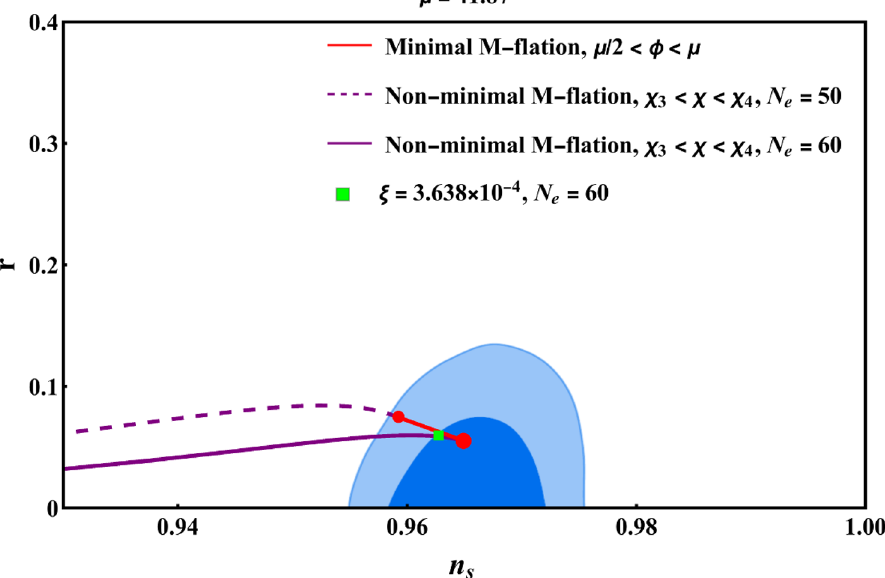
Figure 3 . This (cid:12)gure depicts the evolution of non- M -(cid:13)ation predictions in the hilltop region (cid:31) 2 < (cid:31) < (cid:31) 4 . Enhancing the value of (cid:24) slightly one runs out of the PLANCK 2 (cid:27) viable region in the n S (cid:0) r plane. Also the length of in(cid:13)ation shortens. The green square dot corresponds to the value of (cid:24) for which only the stable part of the potential in this region supports 60 e-foldings of